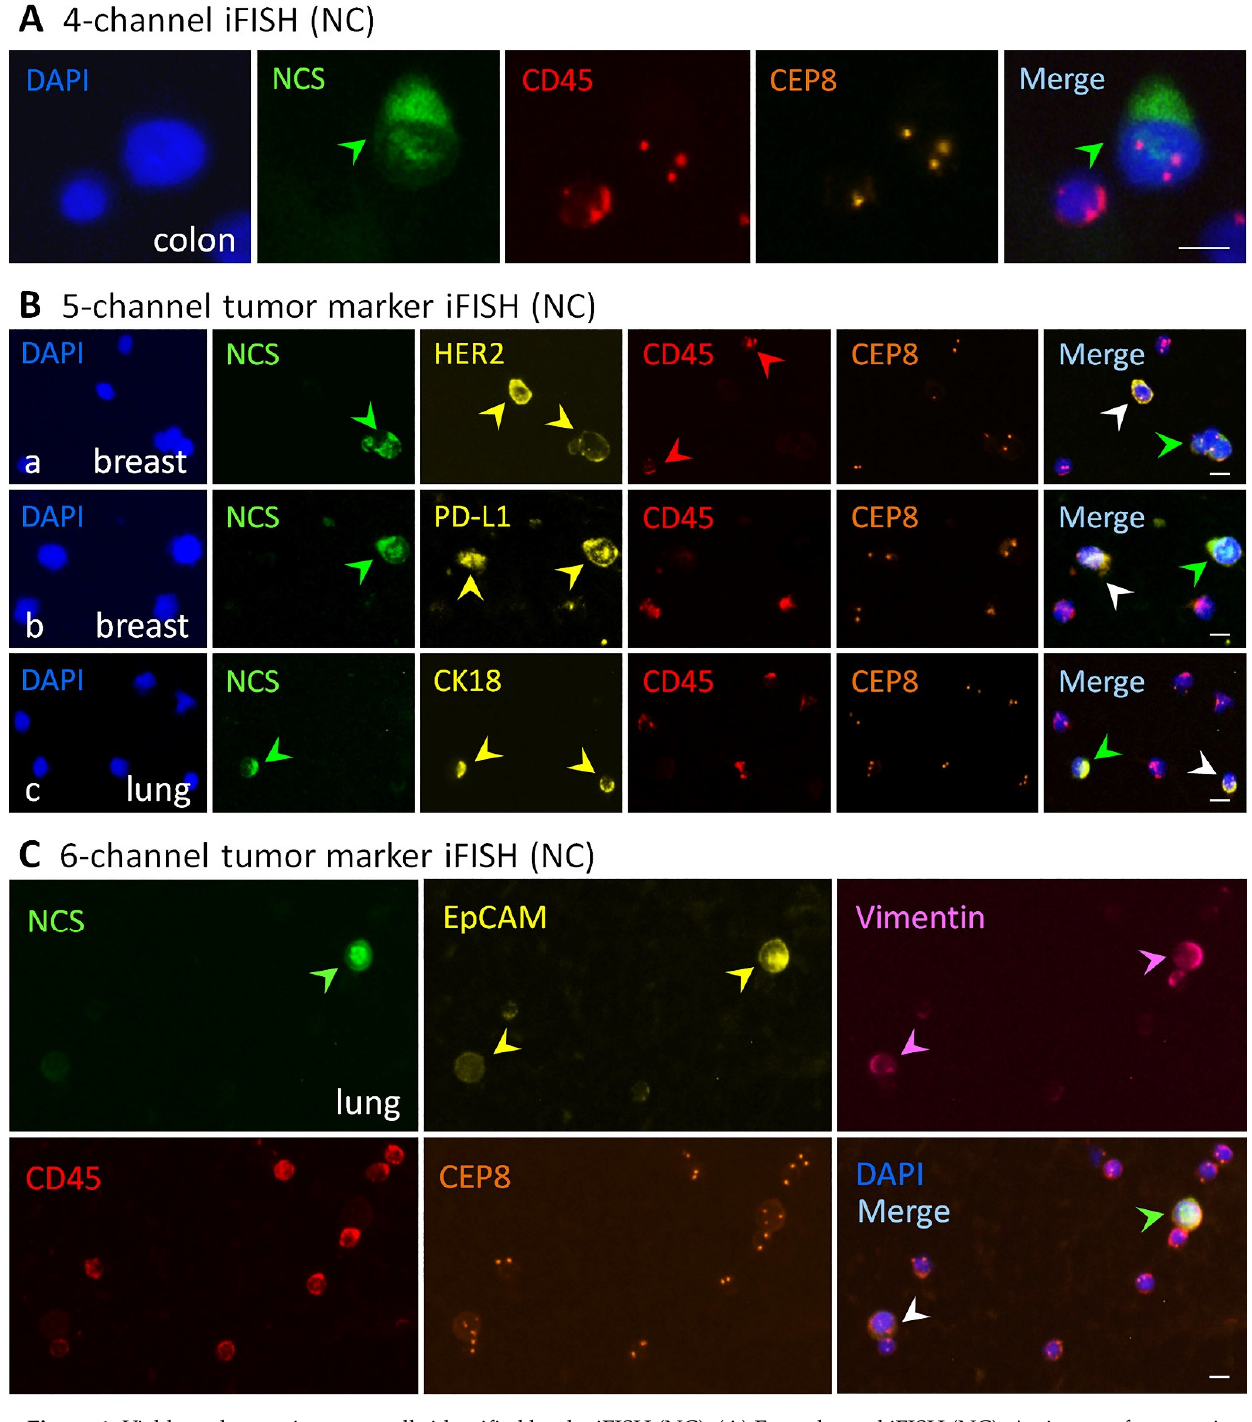
Figure 1. Viable and necrotic cancer cells identified by the iFISH (NC). ( A ) Four-channel iFISH (NC). An image of a necrotic triploid SW480 colon cancer cell, showing a positive necrotic cell staining (NCS, green arrow). ( B ) Five-channel mono-tumor marker iFISH (NC). ( Ba ) An image of a necrotic cell cluster (green arrow) consisting of three HER2 + (yellow arrows) haploid SK-BR-3 breast cancer cells and a viable HER2 + haploid breast cancer cell (white arrow). ( Bb ) a necrotic (green arrow) PD-L1 + (yellow arrows) diploid/near-diploid and a viable PD-L1 + diploid/near-diploid (white arrow) MDA-MB-231 breast cancer cells. ( Bc ) An image of a necrotic (green arrow) CK18 + (yellow arrows) triploid and a viable CK18 + triploid (white arrow) A549 lung cancer cells. ( C ) Six-channel dual-tumor marker iFISH (NC). An image of a necrotic (green arrow) EpCAM high+ (yellow arrows)/Vimentin + (pink arrows) triploid and a viable EpCAM low+ /Vimentin + triploid (white arrow) A549 lung cancer cells. None of the necrotic WBCs are observed in all the images. Bars, 5 µm.